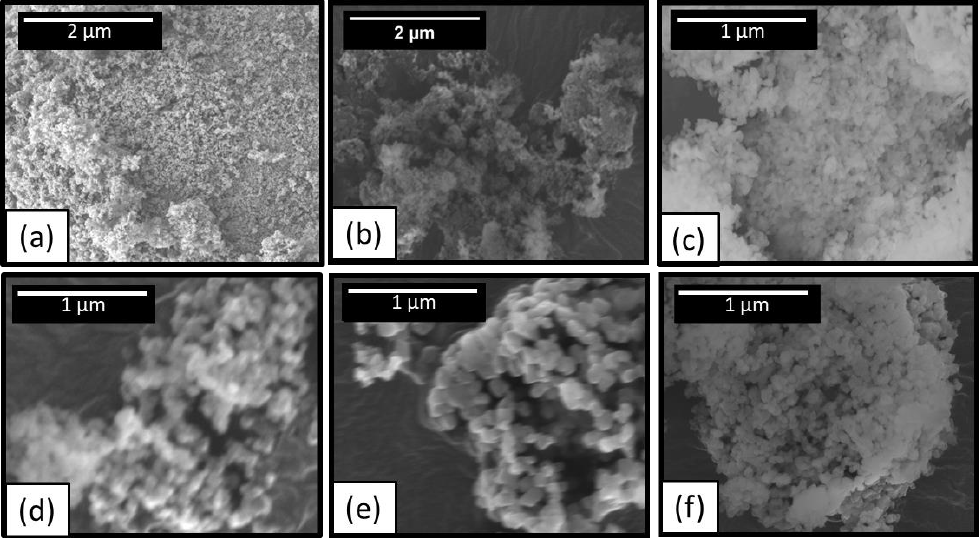
Figure 2. SEM micrographs of nanopowders. ( a ) unreacted δ-Al 2 O 3 . Samples nitrided at ( b ) 1100 °C, ◦ C ( d ) 1300 ◦ C, and ( e ) 1400 ◦ C for 1 h. ( f ) is 1200 ◦ C for 18 h. ( c ) 1200 °C ( d ) 1300 °C, and ( e ) 1400 °C for 1 h. ( f ) is 1200 °C for 18 h. ( c ) 1200